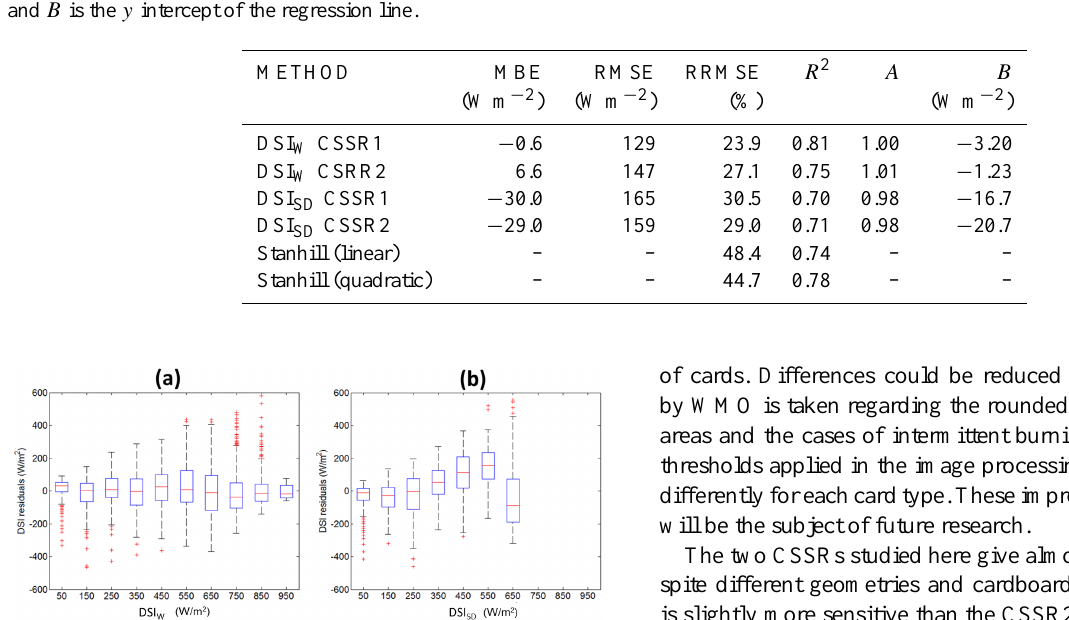
Table 2. Statistical parameters of estimations of hourly DSI when compared with DSI measurements by different methods and instruments (from mean burn width, h 1 , h 2 and hourly sunshine duration, SD1, SD2; Stanhill, 1998). MBE is the mean bias error; RMSE is the root mean square error; RRMSE is the relative root mean square error; R 2 is the coefficient of determination; A is the slope of the regression line; and B is the y intercept of the regression line.